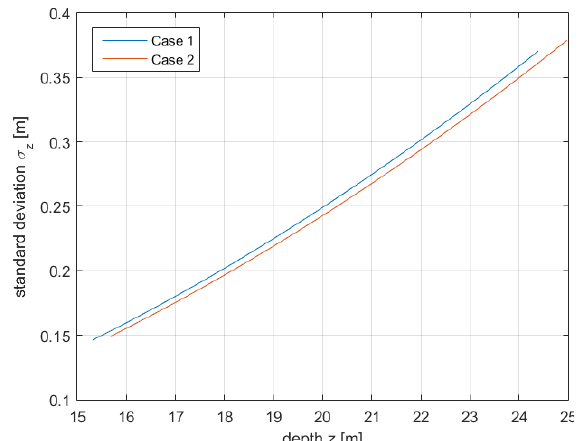
Figure 9. Standard deviation of the calculated depth for cases 1 (upper curve) and 2 (lower